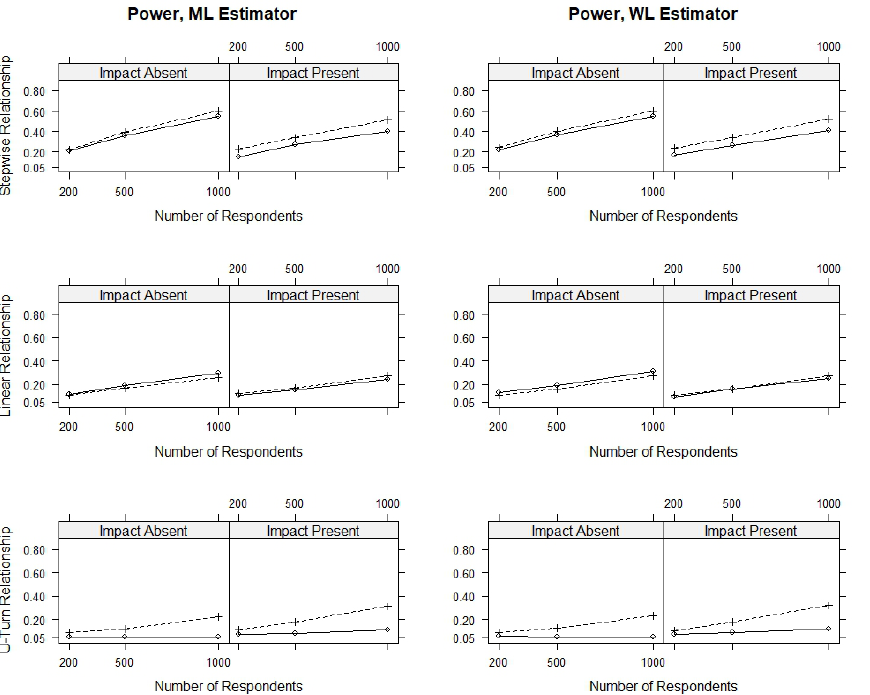
Figure A3. Power of two tests against balanced DIF in the β parameter for modules of 9 items. Only items suspected to be DIF-free are used for ability estimation. The unbroken line presents the results for the linear logistic regression test, the broken line presents the results for the score-based bootstrap test.